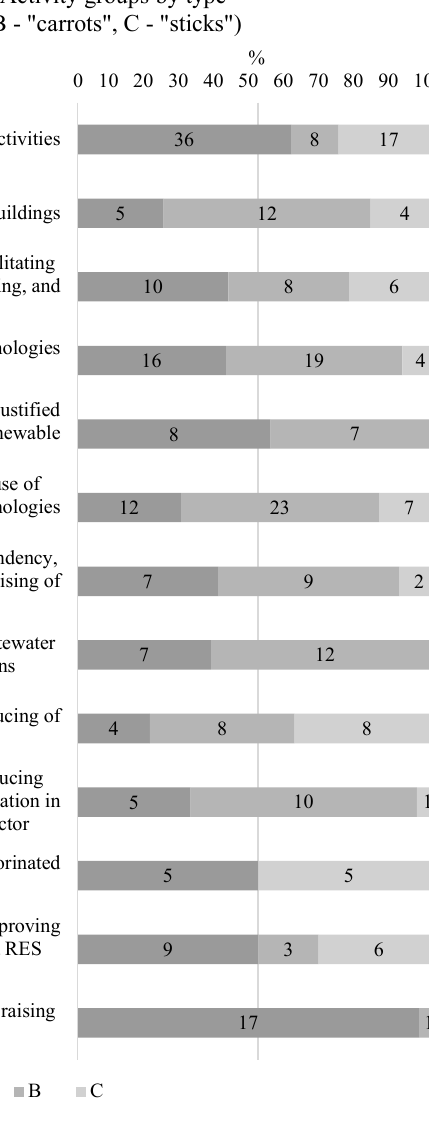
Fig. 4. Proportion of activities in NECP2030 Activity groups by